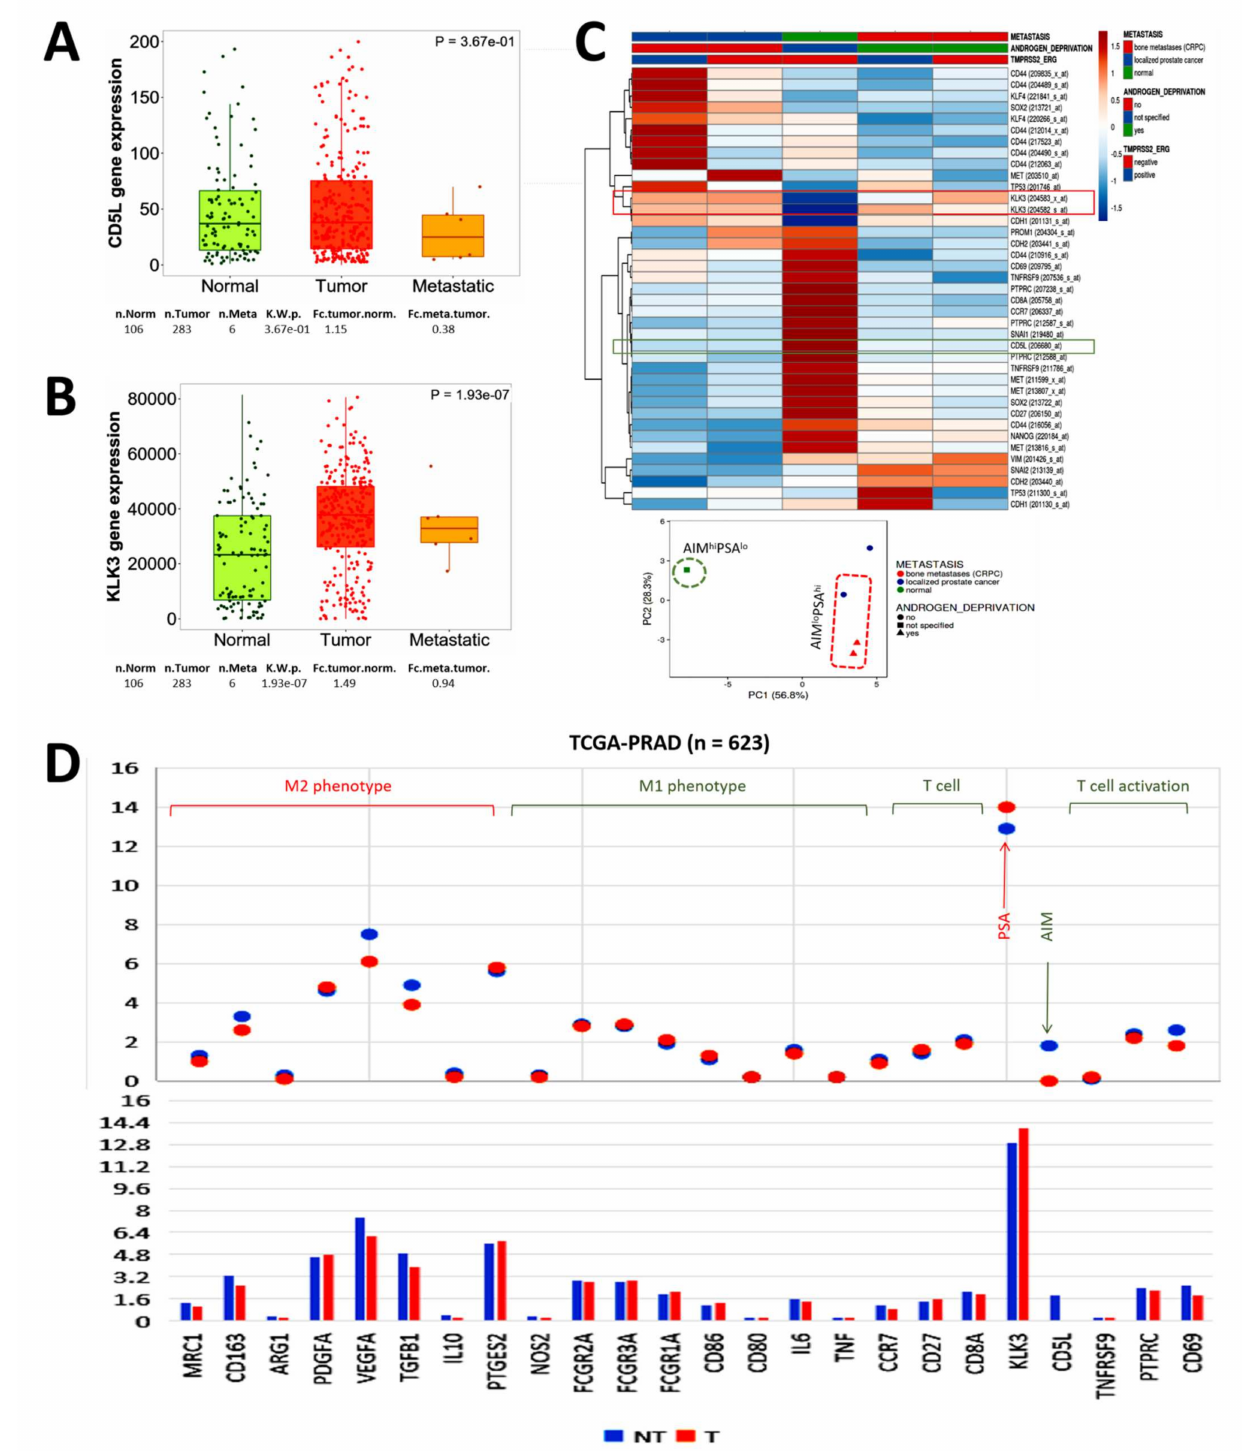
Figure 5. The functional association between PSA and AIM modulates metastasis and mirrors the immunogenicity in patients with prostate cancer. Box and whisker plots showing the differential expression of ( A ) cd5l/aim and ( B ) psa/klk3 genes normal, primary tumor, or metastatic samples from the TNMplot gene chip data. ( C ) Expression heatmap showing the correlation between CD5L , KLK3 , with biomarkers of cancer stemness, epithelial-to-mesenchymal transition, metastasis, or T-cell activation in normal, localized PCa, and bone metastatic CRPC in the GSE32269. ( D ) Graphical representation of the differential expression of CD5L , KLK3 , biomarkers of M1 phenotype, M2 phenotype, and T-cell activation in non-tumor or tumor samples from the TCGA PRAD